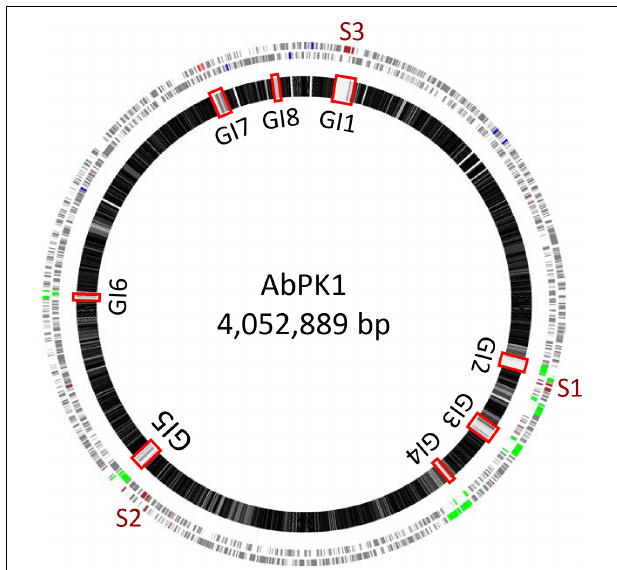
FIGURE 3 | Subtractive hybridization of all 3886 CDSs of the AbPK1 genome against genomes of 2283 other A. baumannii isolates. Chromosome map of AbPK1 (outer two circles) with genes in forward (outermost circle) and reverse orientation. S1 to S3 – siderophore loci; brown – iron acquisition genes; red – antibiotic resistance genes; blue – ribosomal RNA; green – phage. Inner circle: Chromosome of AbPK1 with gray shade-coded genes based on the percentage of compared A. baumannii genomes possessing a homologous sequence. Genes present in near 100% of the genomes are shown in black, genes almost unique to AbPK1 are shown in white. Non-coding regions are shown as gaps. The Genomic Islands (GI) are marked by red rectangles.